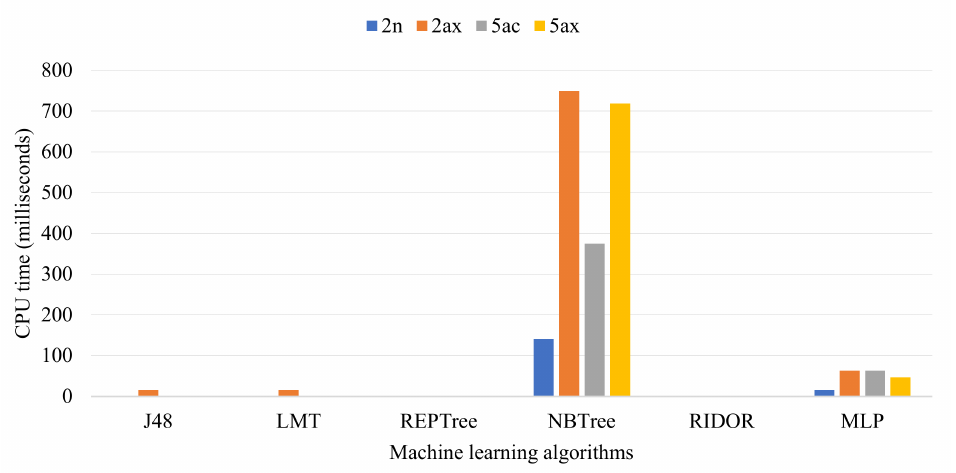
Figure 4. CPU time in milliseconds required for testing phase of 30% of